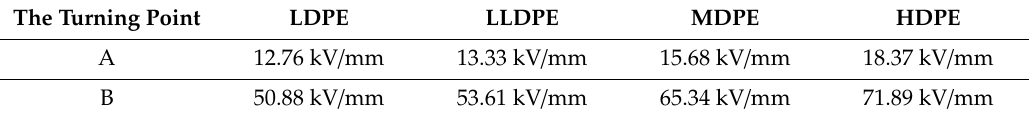
Table 4. The corresponding field strength at di ff erent turning points of di ff erent materials.